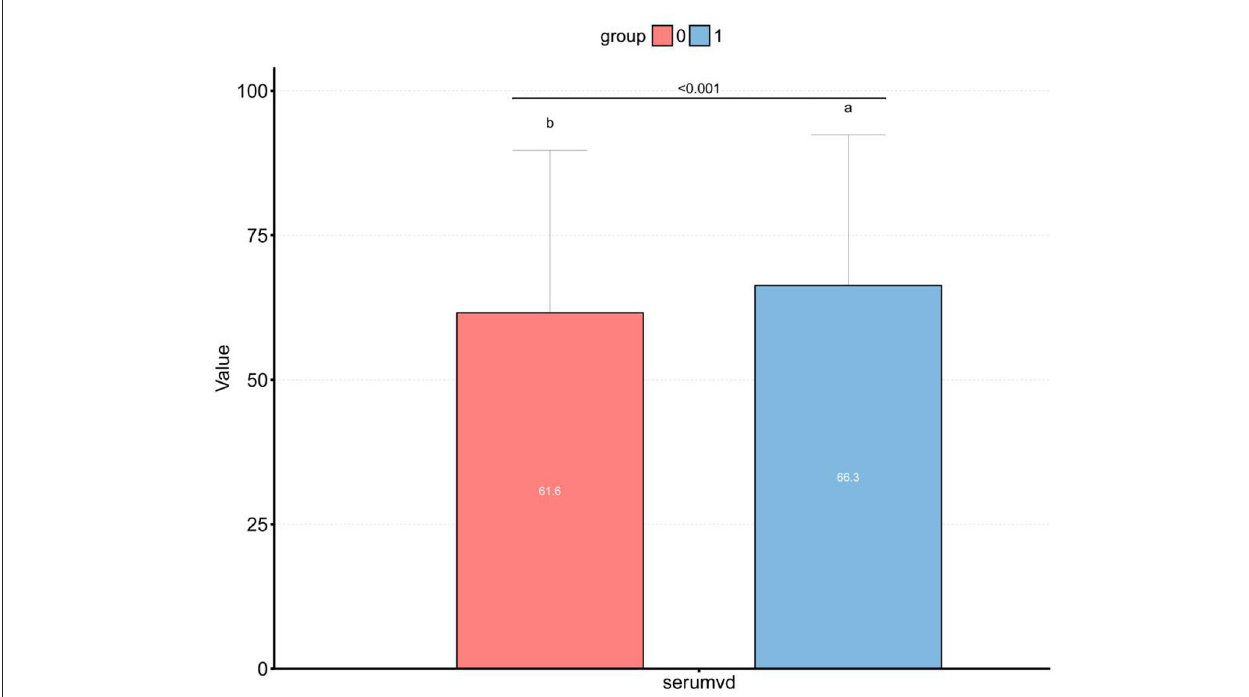
FIGURE 2 | Box plot of the differences between different vitamin D levels in the high and low dietary Magnesium intake groups. (a) 1, high dietary Magnesium intake group; (b) 0, low dietary Magnesium intake group; p <